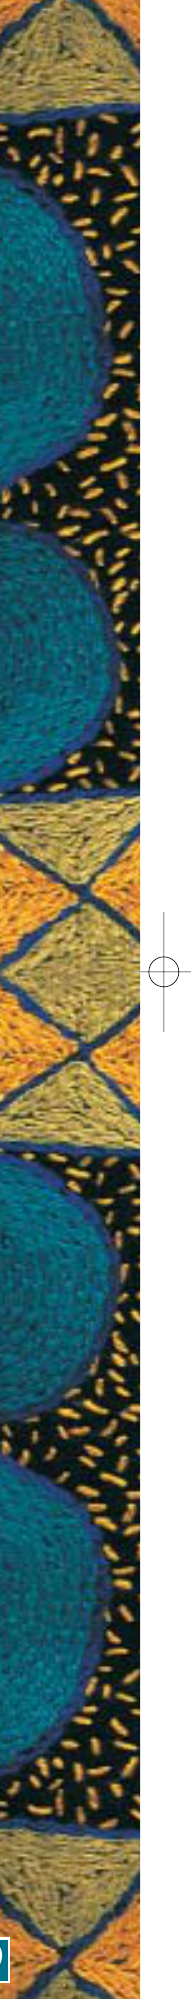
TABLE I. SUMMARY OF ESTIMATED AND PROJECTED IMPACT OF HIV/AIDS ON MORTALITY INDICATORS